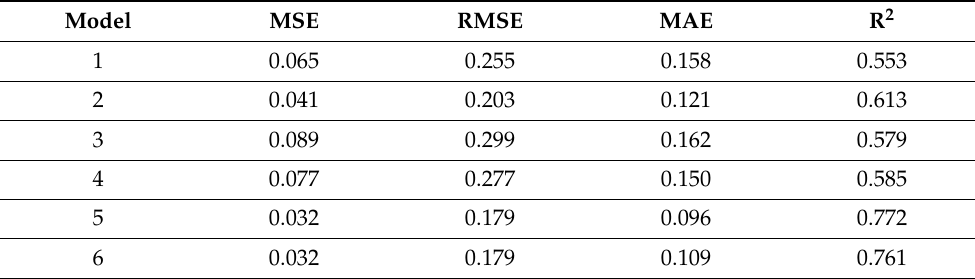
Table 9. Model validation results of set 4 for the slurry test with SAND_PROD_PER_AREA as the